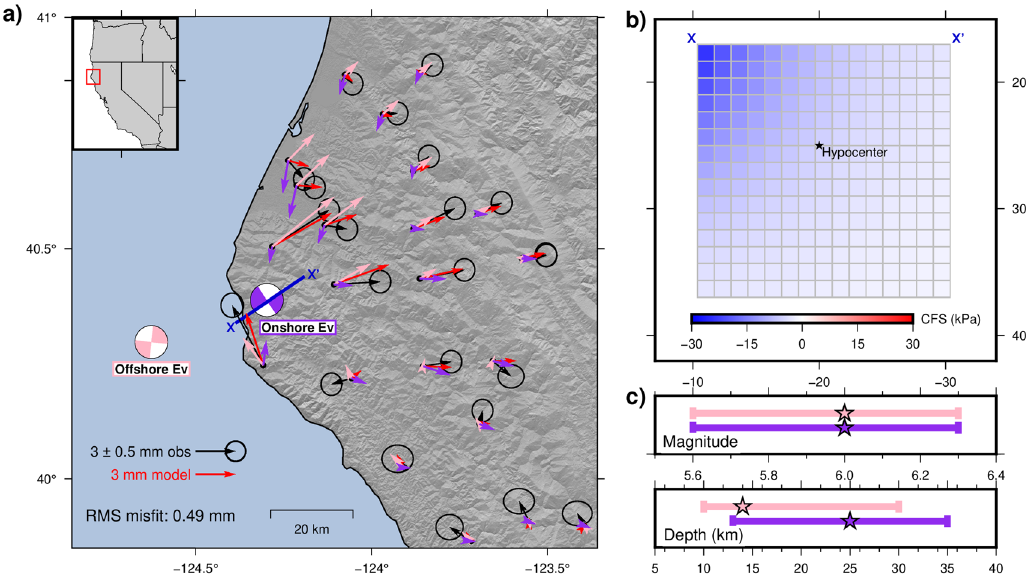
Fig. 2 Combined coseismic GNSS offset model of the two ruptures. a Observed GNSS coseismic offsets (black) and model fi ts (red) from an optimized model of two earthquake point sources, assuming NEIC epicenter locations with vertical strike-slip faults striking 56° (onshore) and 96° (offshore) (Supplementary Table 1). The individual contributions of the offshore and onshore faults are shown in pink and purple, respectively, and their sum is shown in red. The depth and magnitude of each event were selected by grid search. b Coulomb Failure Stress (CFS) calculation for left-lateral slip produced by the offshore earthquake on the rupture plane of the onshore earthquake. The rupture plane is shown in the pro fi le X – X ’ . Positive CFS is encouraging slip; negative is discouraging. c Grid search ranges for depth and magnitude of both events with stars showing the best fi t.